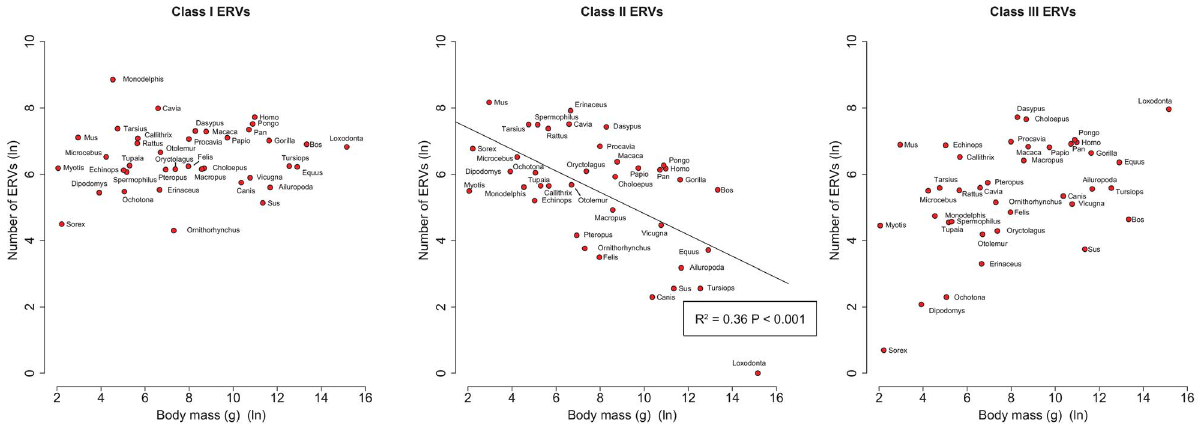
Figure 3. Correlations of number of ERVs against body mass (both log-transformed) by ERV class.